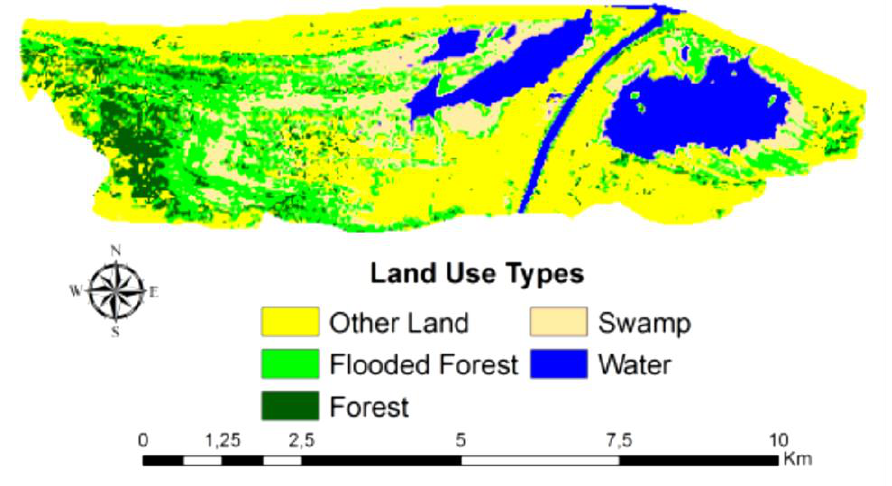
Figure 4. Classified of 2000 image